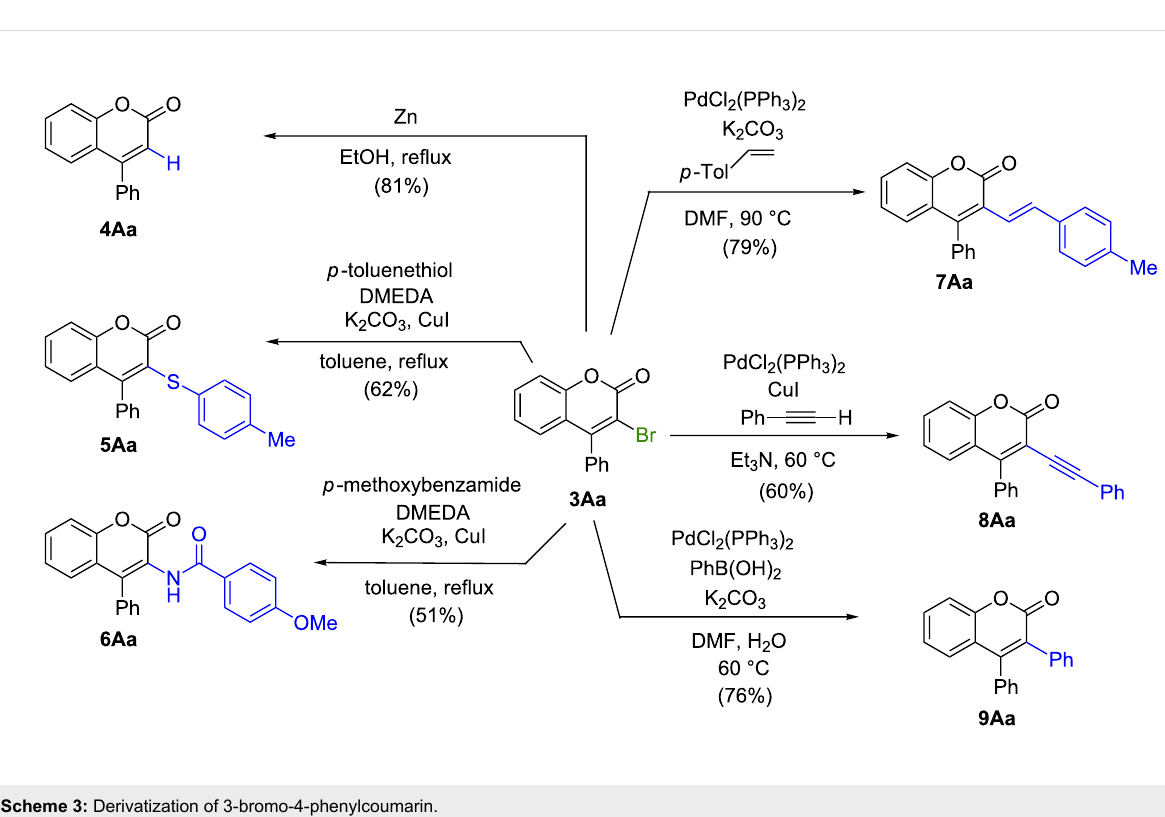
with TBAB and Na 2 S 2 O 8 in a mixture of DCE and water is a radical-mediated bromocyclization reaction. X-ray crystallo- graphic analysis of 3-bromo-7-chloro-4-phenylcoumarin ( 3Da